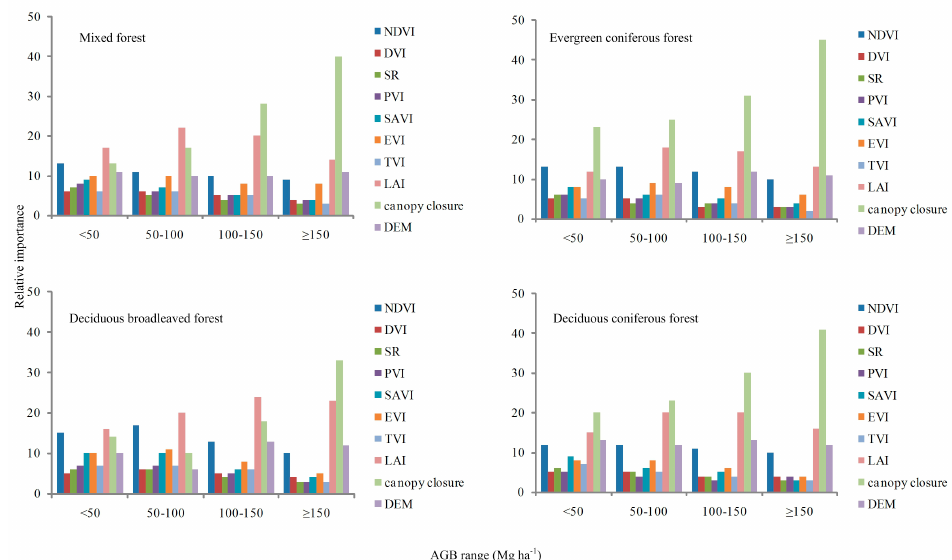
Figure 7. Relative importance of remote sensing variables in modeling AGB of four forest types.